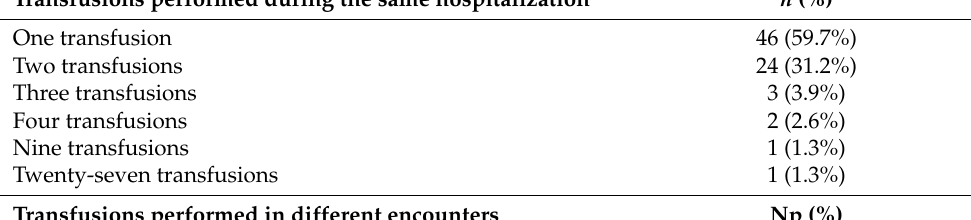
Table S2: Demographic features and agreement with NHS criteria of Blood transfusion